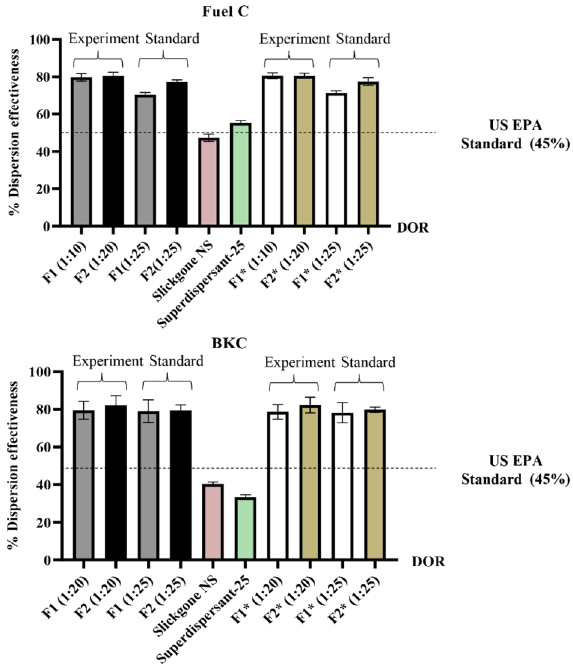
Figure 2. Dispersion effectiveness (%) of biosurfactant-based dispersants and commercial dispersants for fuel oil and BKC crude oil. F1 is an extracellular glycolipid:lipopeptide mixture, while F2 is a cell-bound glycolipid:lipopeptide mixture. The star indicates that glycolipids in the formulation were obtained from waste coconut water supplemented with waste frying oil. *Experiment is the DOR obtained from the condition in Table 1, while standard is the recommended DOR (1:25) from the standard method for baffled flask test.